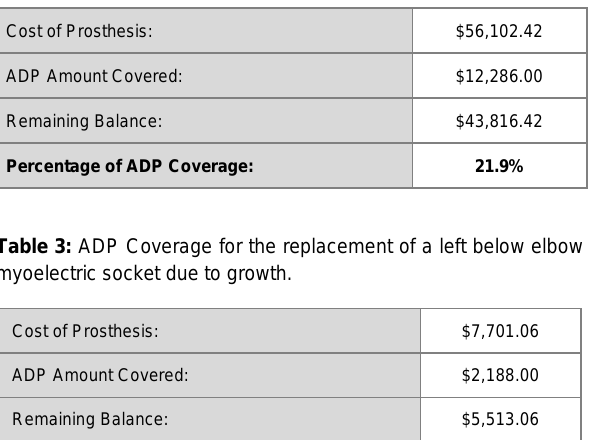
Table 2 : ADP Coverage for an above knee prosthesis with a microprocessor knee unit.